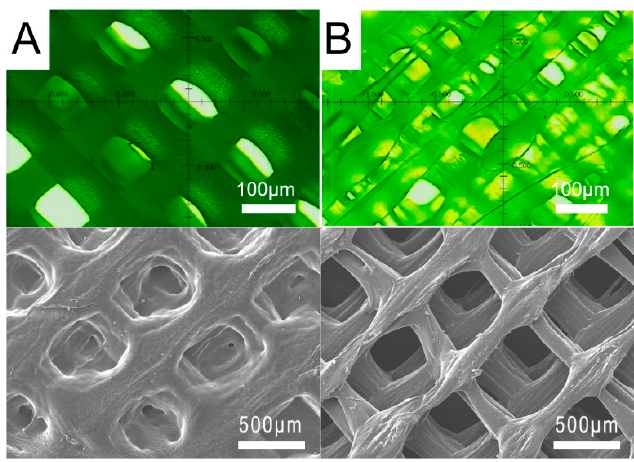
Figure 10. Profile projector and FESEM images of parts fabricated with fill densities of ( A ) 80%, ( B ) 65%.